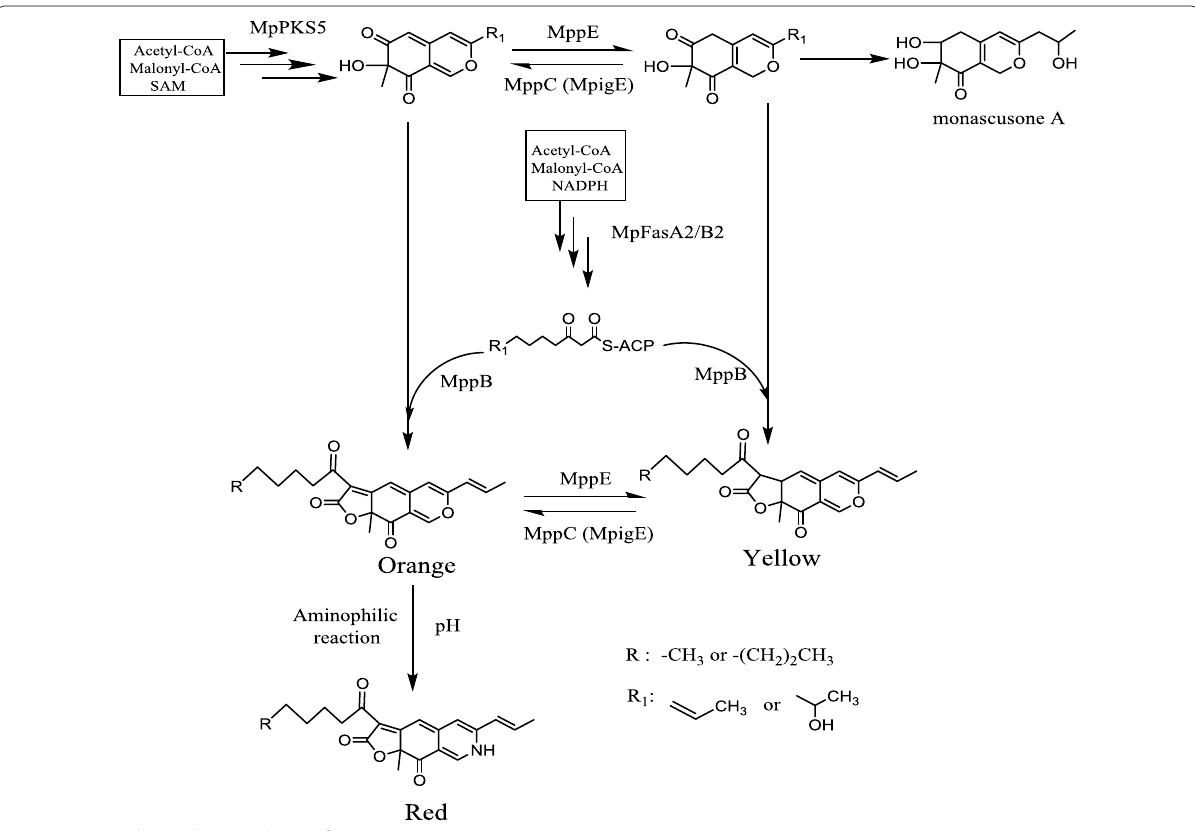
Fig. 5 Putative biosynthetic pathway of Monascus